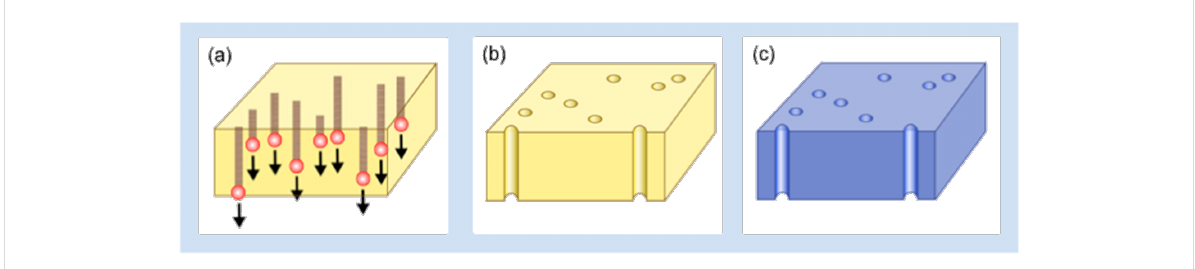
Figure 1: Schematics of the fabrication of SiO 2 coated membranes: (a) irradiation of PC foil with GeV heavy ions, (b) chemical etching of ion tracks to form cylindrical nanochannels, (c) ALD conformal coating of porous membrane.